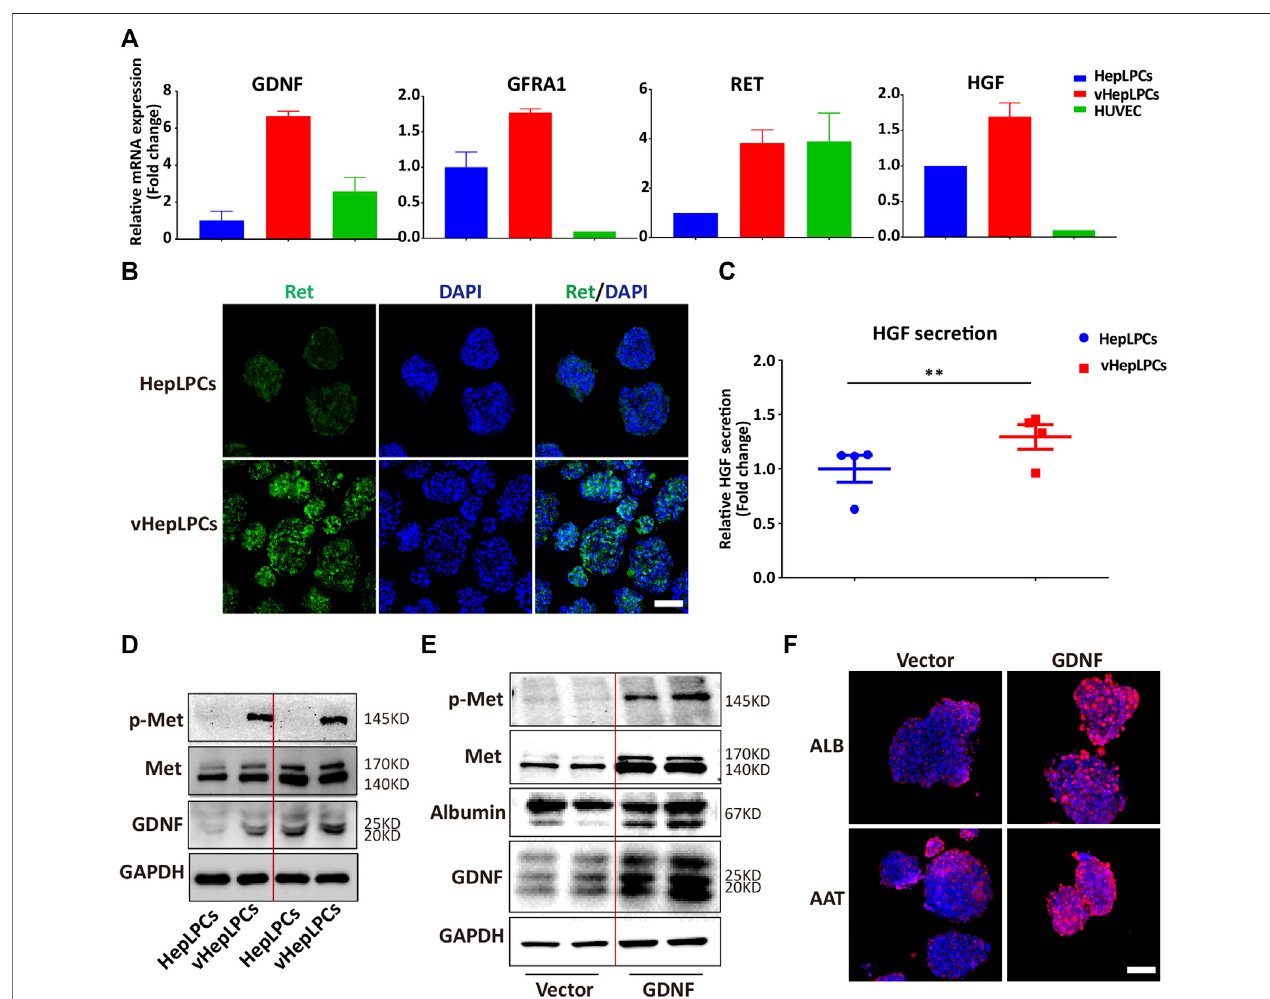
FIGURE 5 | HUVECs produced GDNF that promoted HepLPC maturation by phosphorylation of Met. (A) Gene expression was analyzed by qRT-PCR. GDNF, GDNF receptors (Ret, GARF1), and HGF were analyzed. Data are normalized to HepLPCs. (B) Immuno fl uorescence con fi rmed that the expression of the GDNF receptor, Ret, increased after co-culture. (C) Quantitative analysis of HGF secretion in supernatants. Data are normalized to HepLPCs ( n (cid:2) 4 per group). (D) The expression of different batches of Met, p-Met, and GDNF after co-culture was assessed using western blots ( n (cid:2) 3 per group). (E) Western blots were used to detect GNDF, Met, and p-Met in HepLPCs and HepLPCs that overexpressed GDNF ( n (cid:2) 3 per group). (F) Immuno fl uorescent staining analyses of the expression of hepatic function markers (ALB, AAT) in HepLPCs and HepLPCs that overexpressed GDNF. Nuclei were counterstained with DAPI.